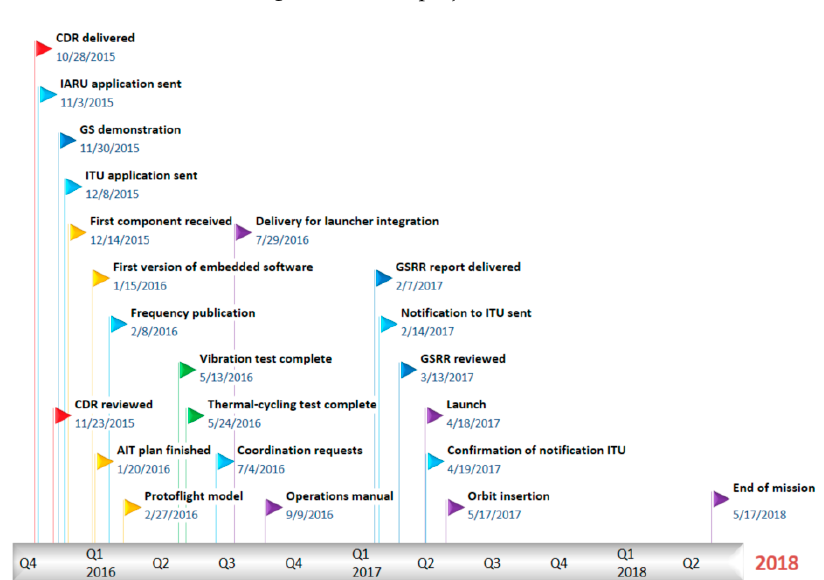
Figure 1. SE01 ′ s project timeline.